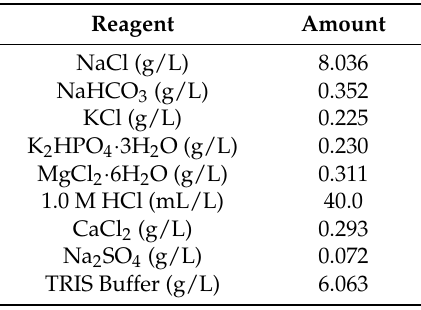
Table 2. Chemical composition of simulated body fluid